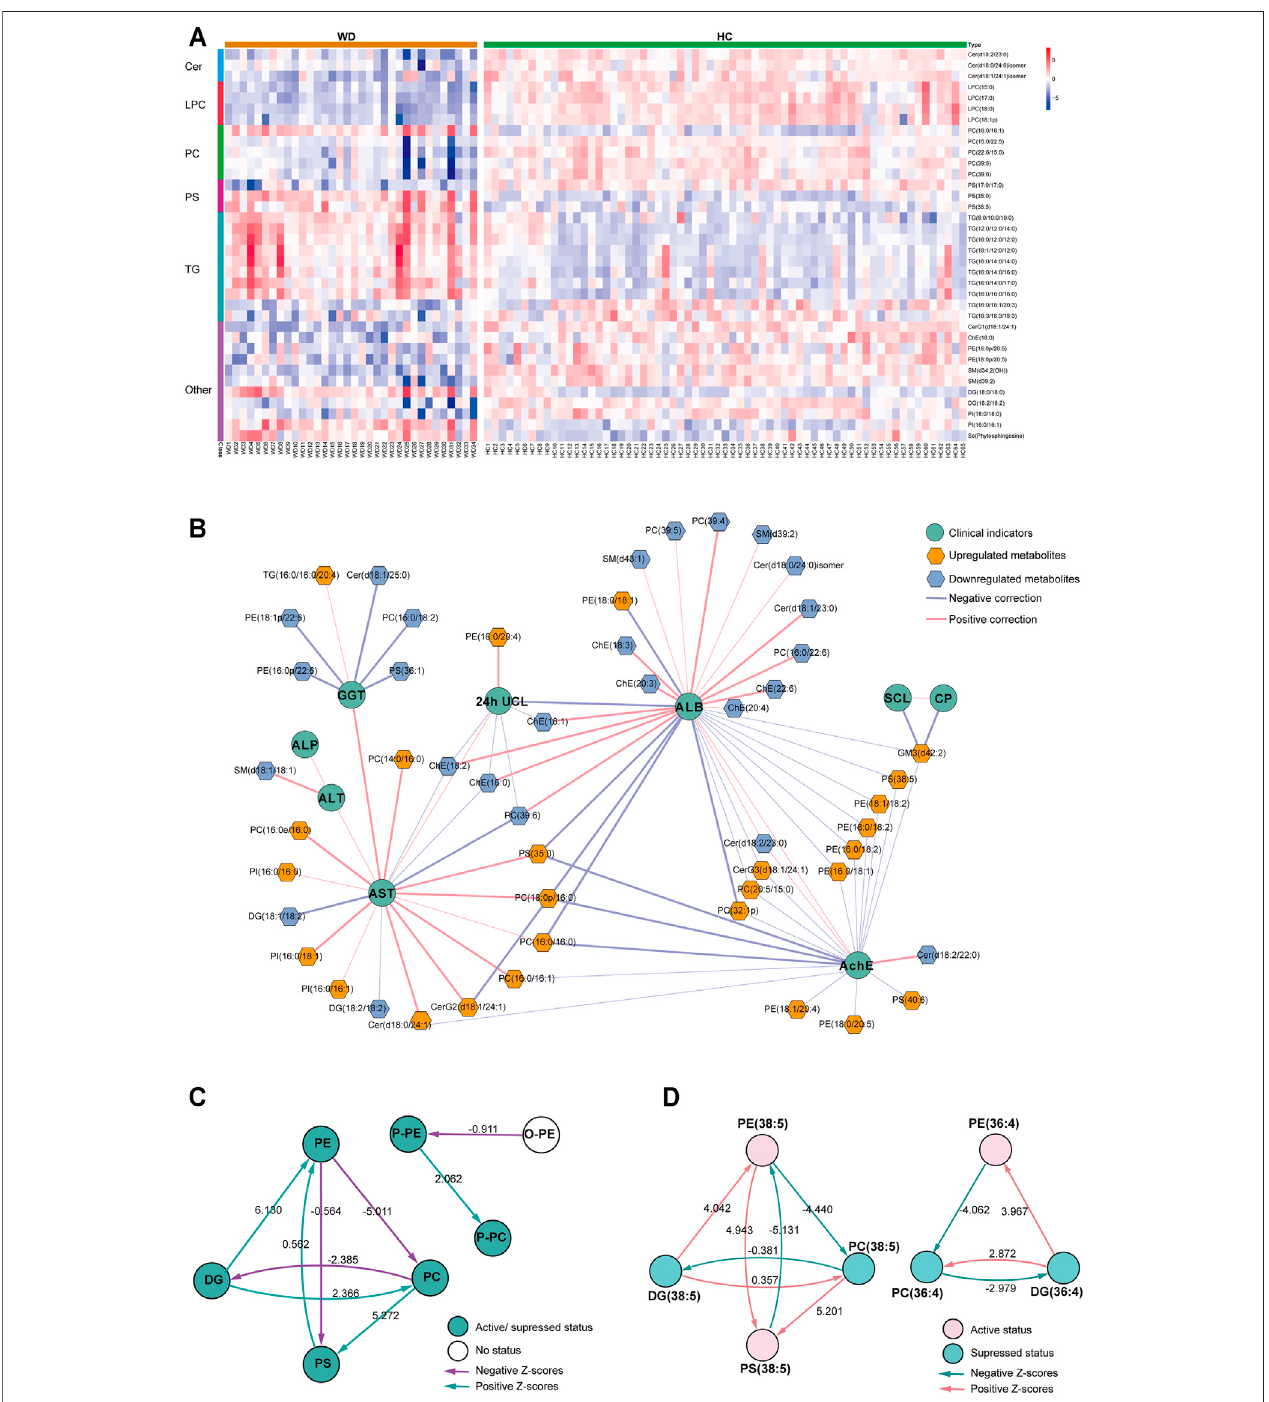
FIGURE 3 | Metabolomic pro fi les differ between WD and HC. (A) Heat map of the 36 differential lipids between WD and HC. (B) Correlation network of differential metabolites and clinical indicators in WD and HC. The connections between two nodes were established by Pearson correlation (Student ’ s t-test, FDR < 0.05). CP (cid:2) ceruloplasmin; SCL (cid:2) serum copper level; 24-h UCL (cid:2) 24-h urinal copper level; ALT (cid:2) alanine transaminase; AST (cid:2) aspartate transaminase; GGT (cid:2) γ -glutamyltransferase;ALP (cid:2) alkalinephosphatase;AchE (cid:2) acetylcholineesterase; ALB (cid:2) albumin. (C) Lipidsubclasscorrelation networkofdifferentiallyabundant metabolites in WD and HC. (D) Lipid molecular species correlation network of differentially abundant metabolites in WD and HC.